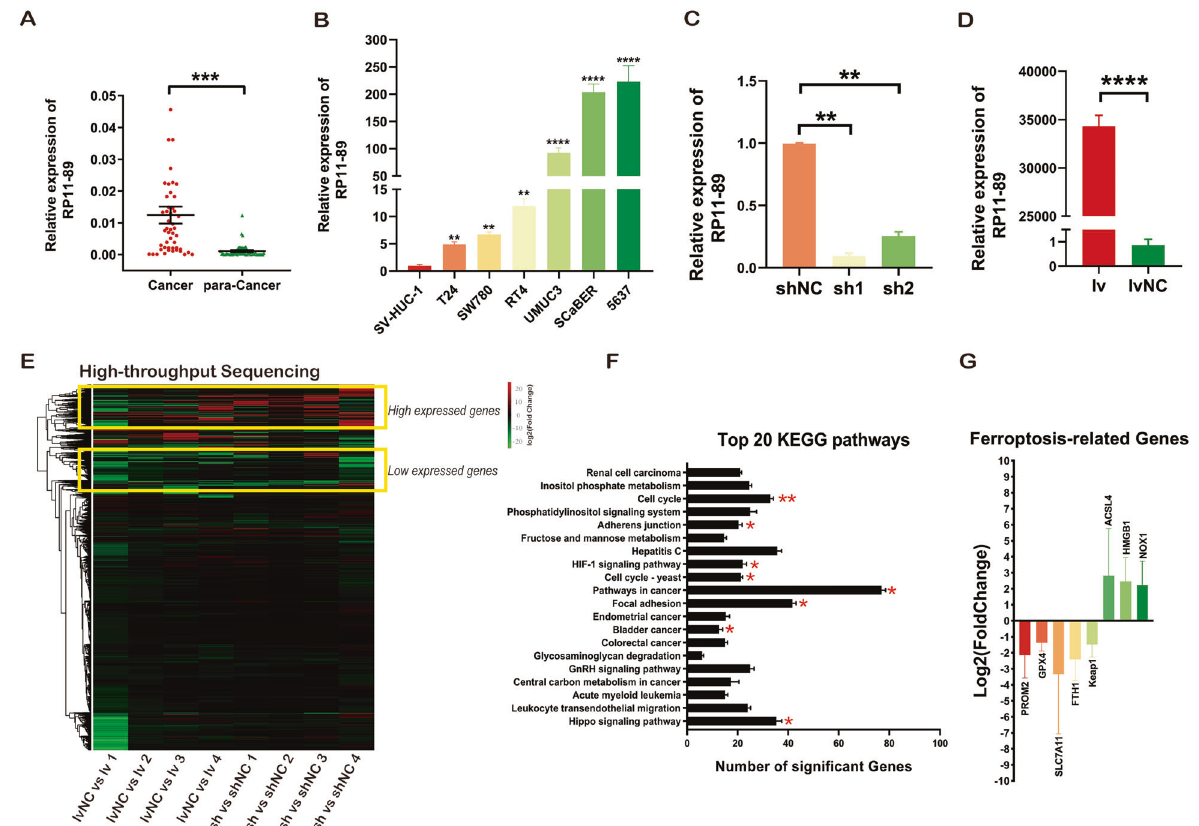
Fig. 1 Dysregulated expression of RP11-89 and its association with ferroptosis in BLCA tumorigenesis. A RP11-89 expression in 49 paired BLCA and normal bladder tissues. B RP11-89 expression in BLCA cell lines and the SV-HUC 1 cell line (an immortalized human normal urothelial cell line). C RT-qPCR showed the knockdown ef fi ciency of sh1-RP11-89 and sh2-RP11-89 shRNA plasmids in the 5637 Cell line. D RT- qPCR showed the overexpression ef fi ciency of lv-RP11-89 and lvNC-RP11-89 plasmids in the T24 Cell line. E Heatmap depicting the log2FC values of differentially expressed genes from high-throughput sequencing of sh1-RP11-89 5637 Cell and shNC-RP11-89 5637 Cell as well as lvNC-RP11-89 T24 Cell and lv-RP11-89 T24 Cell in four pairs of samples. F Top 20 KEGG analysis suggested that RP11-89 exhibits roles in BLCA tumorigenesis via multiple pathways. G Histogram showing log2FC values of ferroptosis-related genes including downregulated and upregulated genes. Results are presented as mean ± SD. * P < 0.05; ** P < 0.01, *** P < 0.001, **** P < 0.0001. Data were obtained from at least three independent